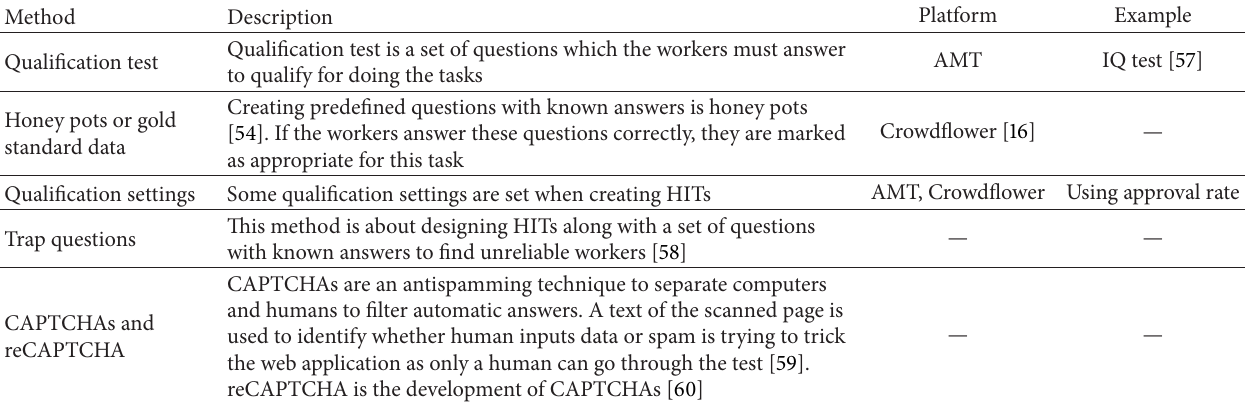
Table 6: Design-time